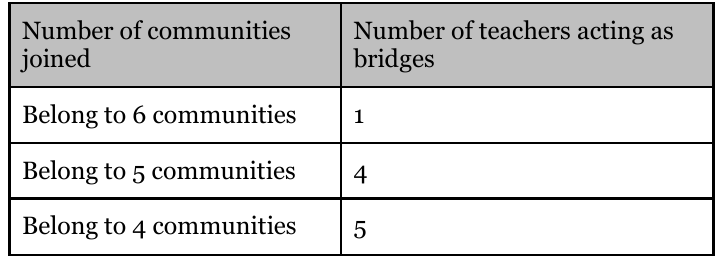
Number of Teachers Acting as